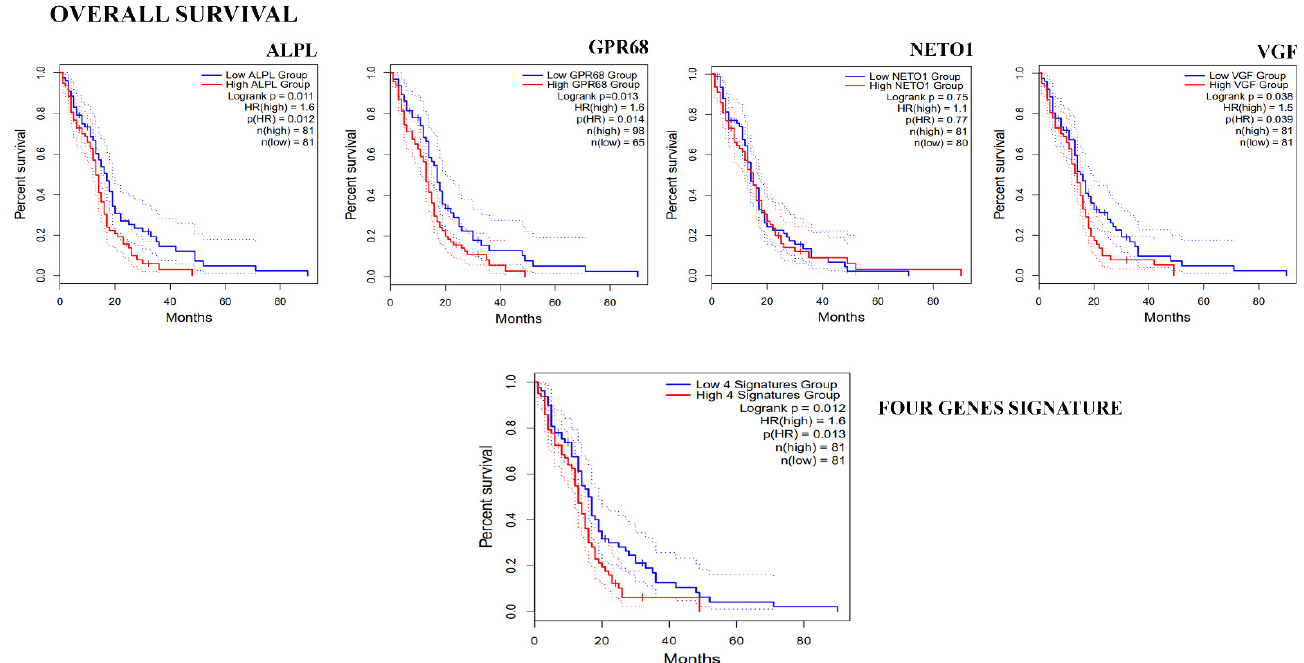
Figure 2. Gene expression profiling of the four genes down-regulated in GASC-LS in the TCGA- GBM RNA-seq dataset. Box plots represent the gene expression levels in the TCGA-GBM dataset (n = 163) and in the TCGA-GTEx matched normal samples (n = 207) of the genes with a significant down-regulation in GASC-LS, identified with the RT2 Profiler array. Data were obtained and plot-